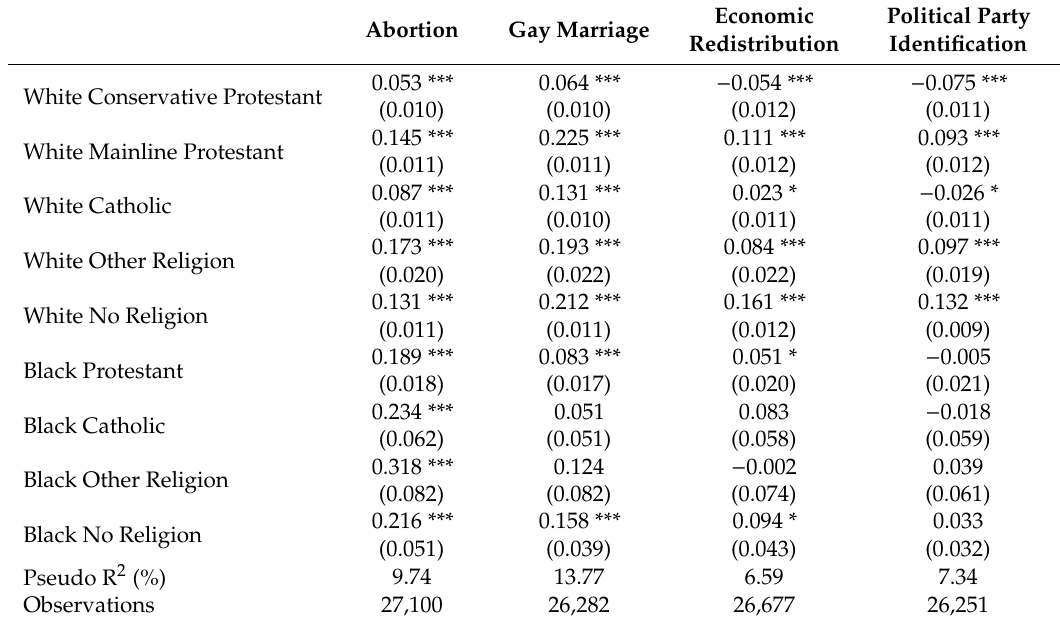
Table A3. E ff ects of education in logit models with the interaction of education and nine category religion on political